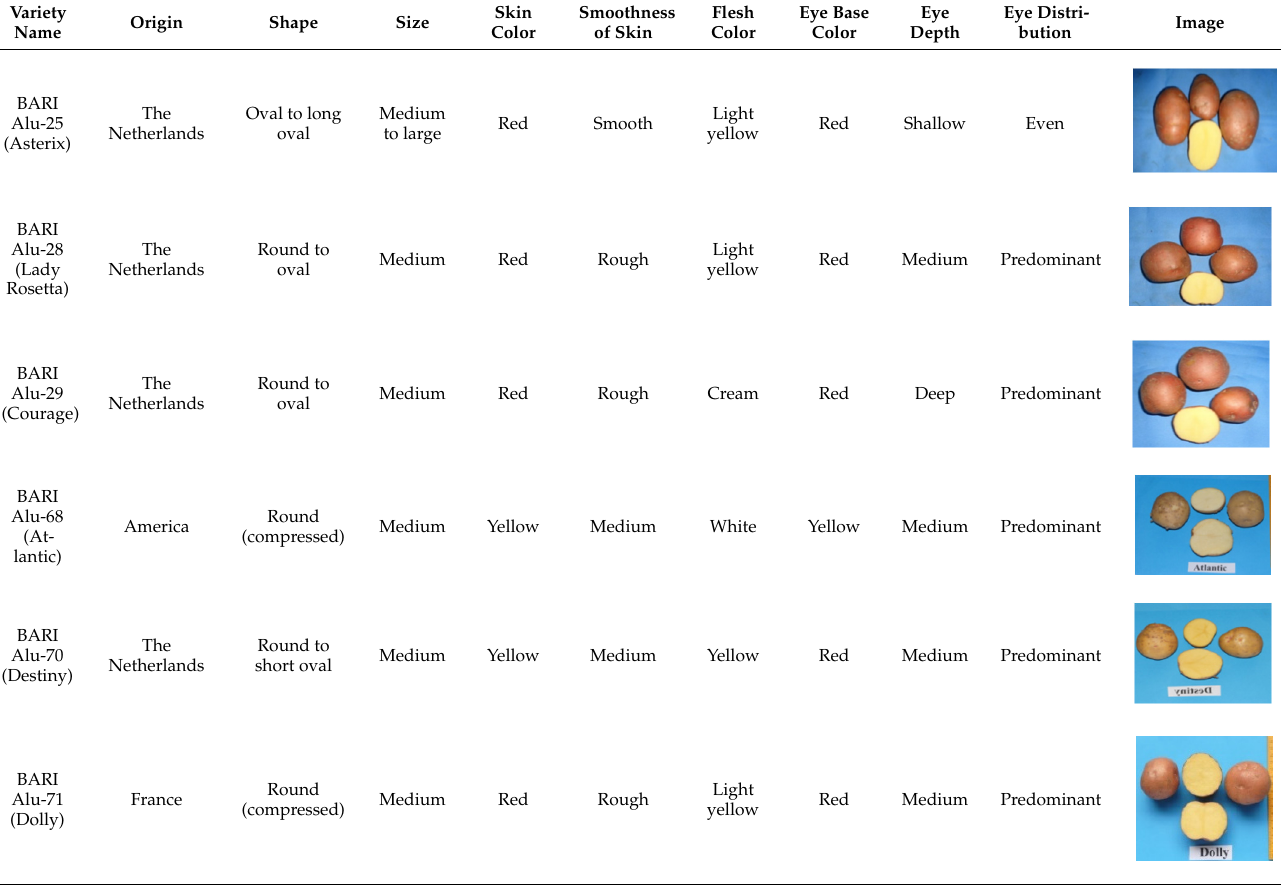
Table 2. List of potato varieties used in the study along with their characteristics.